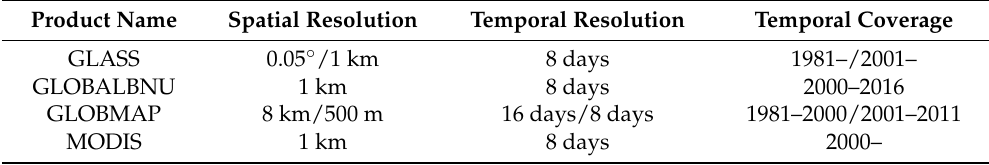
Table 1. Main information on the LAI products under